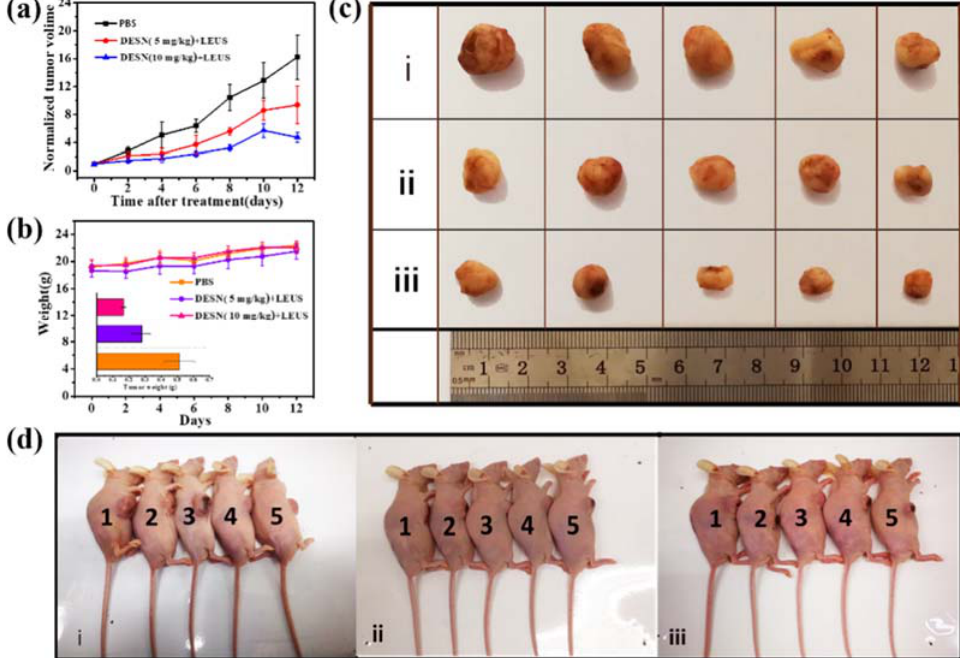
Figure 8. In vivo therapeutic efficacy of DESN under low-energy ultrasound irradiation: ( a ) Time-dependent tumor growth curves ( n = 5, mean ± SD) after different treatments (control, 5 mg/kg DESN + LEUS, 10 mg/kg DESN + LEUS); ( b ) Time-dependent body-weight curves of nude mice after different treatments. Inset: tumor weights of mice 13 days after the treatments. Valued are means ± s. e. m. ( n = 5 mice per group); ( c ) The images of tumor volume for nude mice with 4T1 cancer cells treated with blank control i, DESN (5 mg/kg) + LEUS ii, and DESN (10mg/kg) + LEUS iii and ( d ) Nude mice images of mice treated with one blank control, ii DESN (5 mg/kg) + LEUS, and iii DESN (10 mg/kg) + LEUS. The therapeutic efficacy of DESN under LEUS was obvious. As the concentration of DESN increased, the growth of the tumor was more prominent.